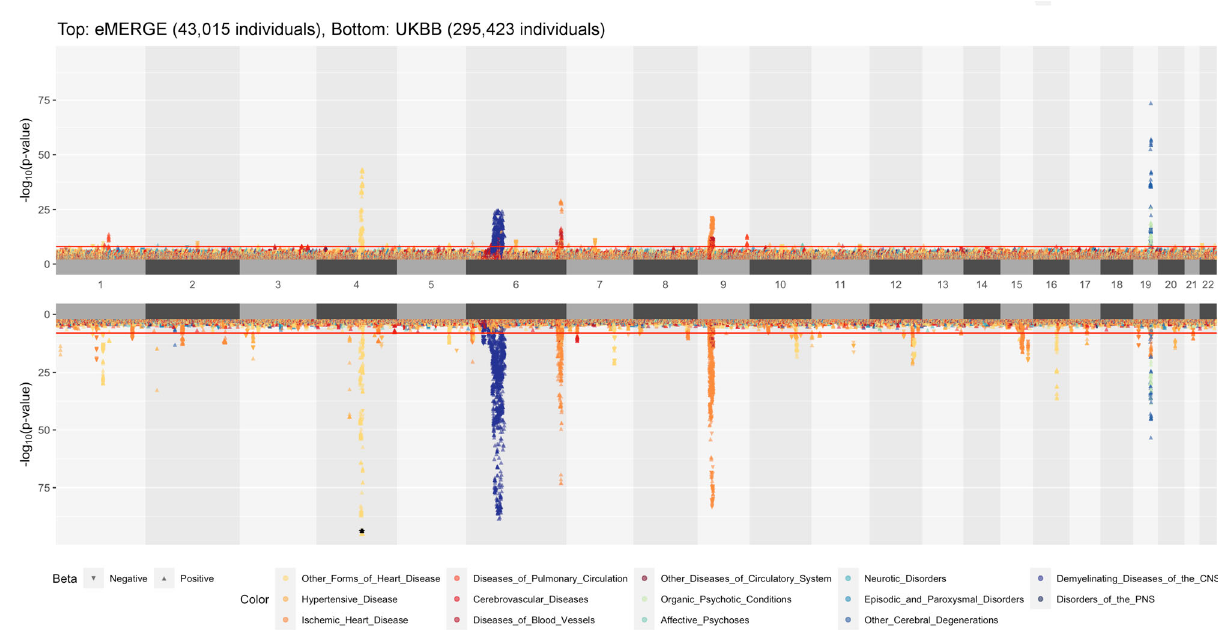
Fig. 1 Landscape of PheWAS results. A position-to-position comparison of PheWAS results between eMERGE and UKBB. eMERGE PheWAS was performed genome-wide as the discovery analysis. UKBB PheWAS included the SNPs with p ≤ 1 × 10 − 4 across all tested phenotypes in eMERGE; only these SNPs were evaluated in the replication analysis. The direction of each triangle indicates the direction of genetic effect. Colors denote various disease groups. The assignment of ICD codes to disease groups can be found in Supplementary Data 1. The red line indicates the genome-wide signi fi cance threshold p -value of 1 × 10 − 8 . To reduce the margin induced by the extremely small p -values, we have collapsed SNPs with p -value < 1 × 10 − 95 into one overlapping triangle indicated by an asterisk on chromosome 4 for